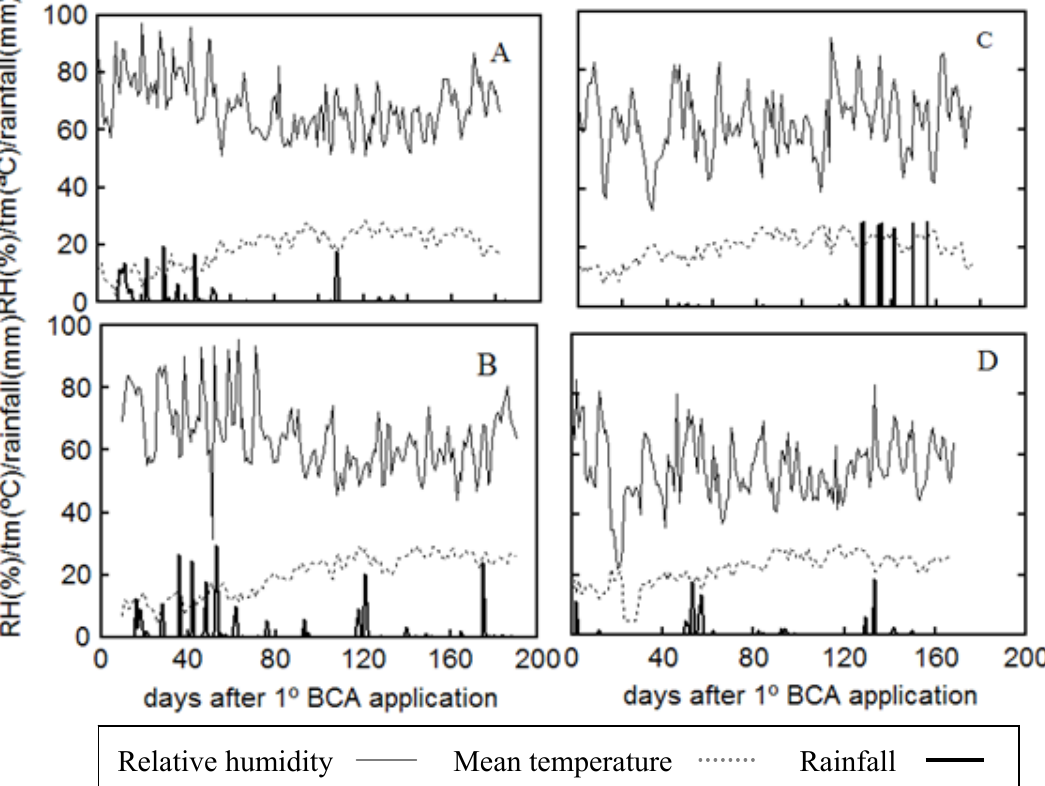
Figure 3. Daily rainfall (mm), mean temperature (tm ºC) and relative humidity (% RH) during ( A ) 2004 and ( B ) 2005 in the commercial orchard in Alfarrás, Spain, and ( C ) 2004 and ( D ) 2005 in the commercial orchard in Sudanell,